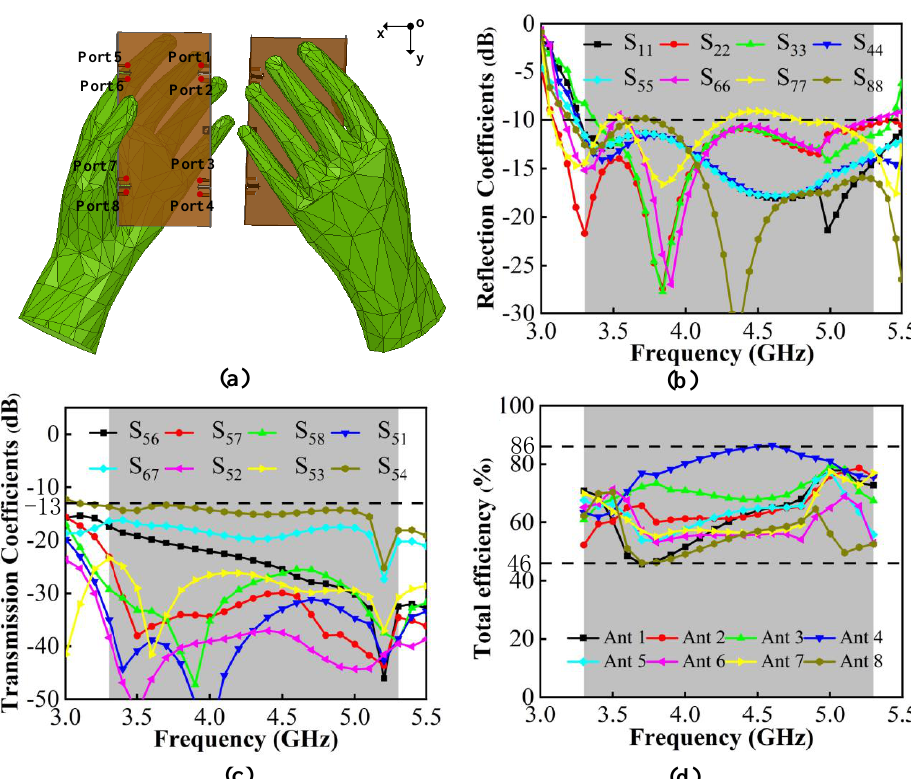
Figure 21. ( a ) MIMO system with user ’ s left hand model. ( b ) Simulated reflection coefficients. ( c ) Simulated transmission coefficients. ( d ) Simulated total efficiency.